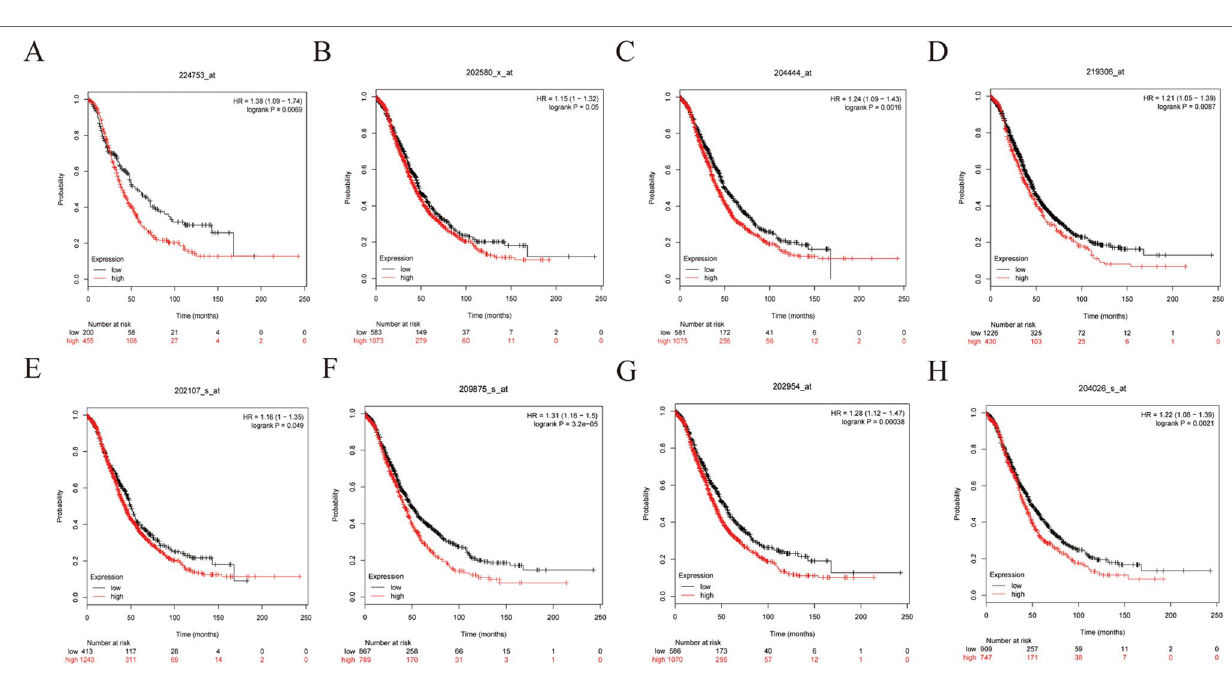
FIgUrE 9 | Overall survival (OS) curves of eight hub genes. (A) CDCA5, (B) FOXM1, (C) KIF11, (D) KIF15, (E) MCM2, (F) SPP1, (g) UBE2C, (h) ZWINT.